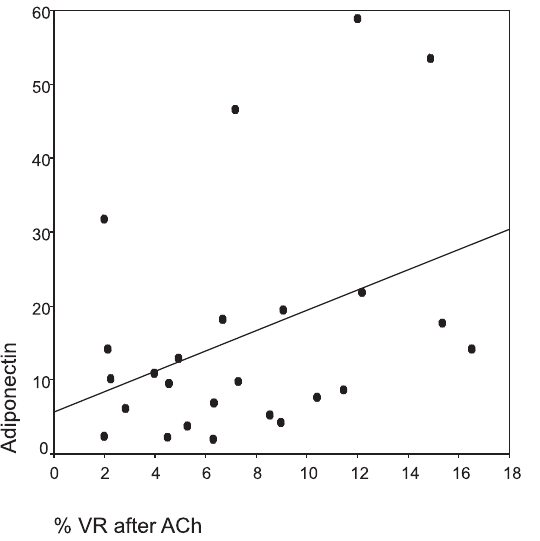
Figure 4 - Relationship between forearm blood flow increment (%) and resistin level in the pooled